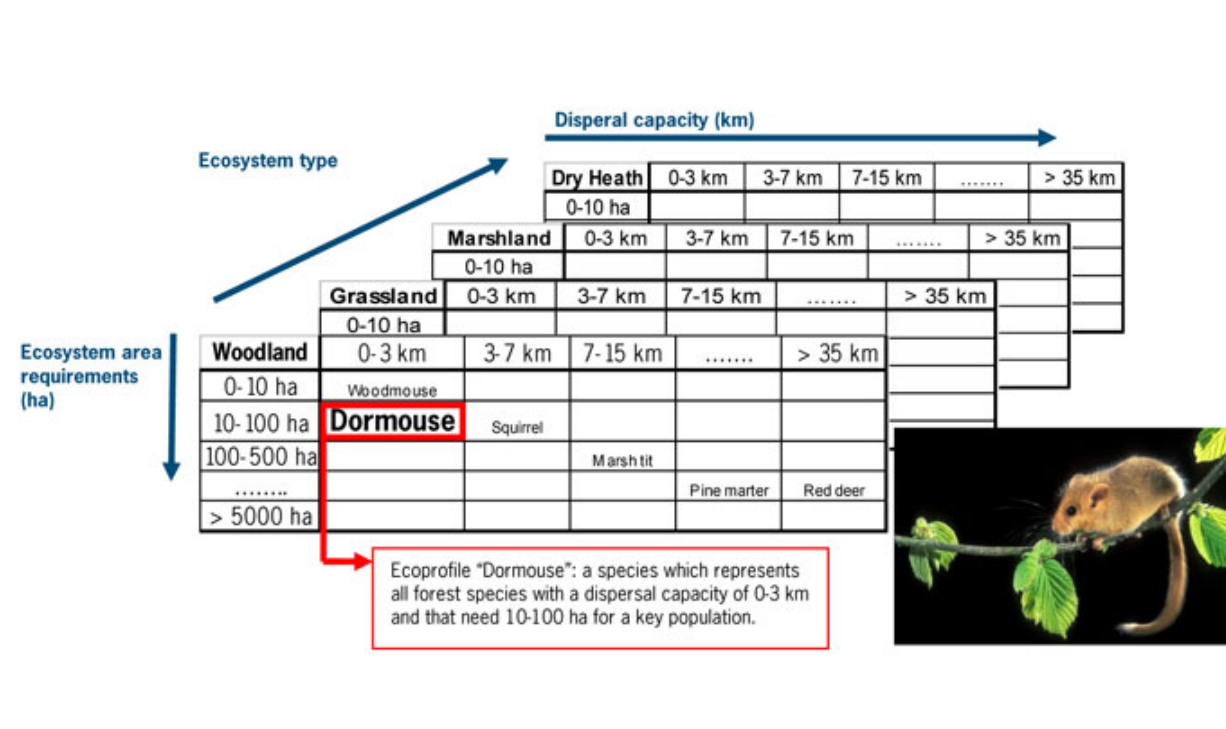
Fig. 2. Design of three-dimensional ecoprofile matrices, one per identified ecosystem type, based on the carrying capacity of regional ecosystems (vertical axis), and the inter-patch distance that can be crossed during dispersal. Species are assigned to cells in the matrix by their habitat preference, individual habitat area requirements, and dispersal capacity. Each cell in the matrices represents one ecological